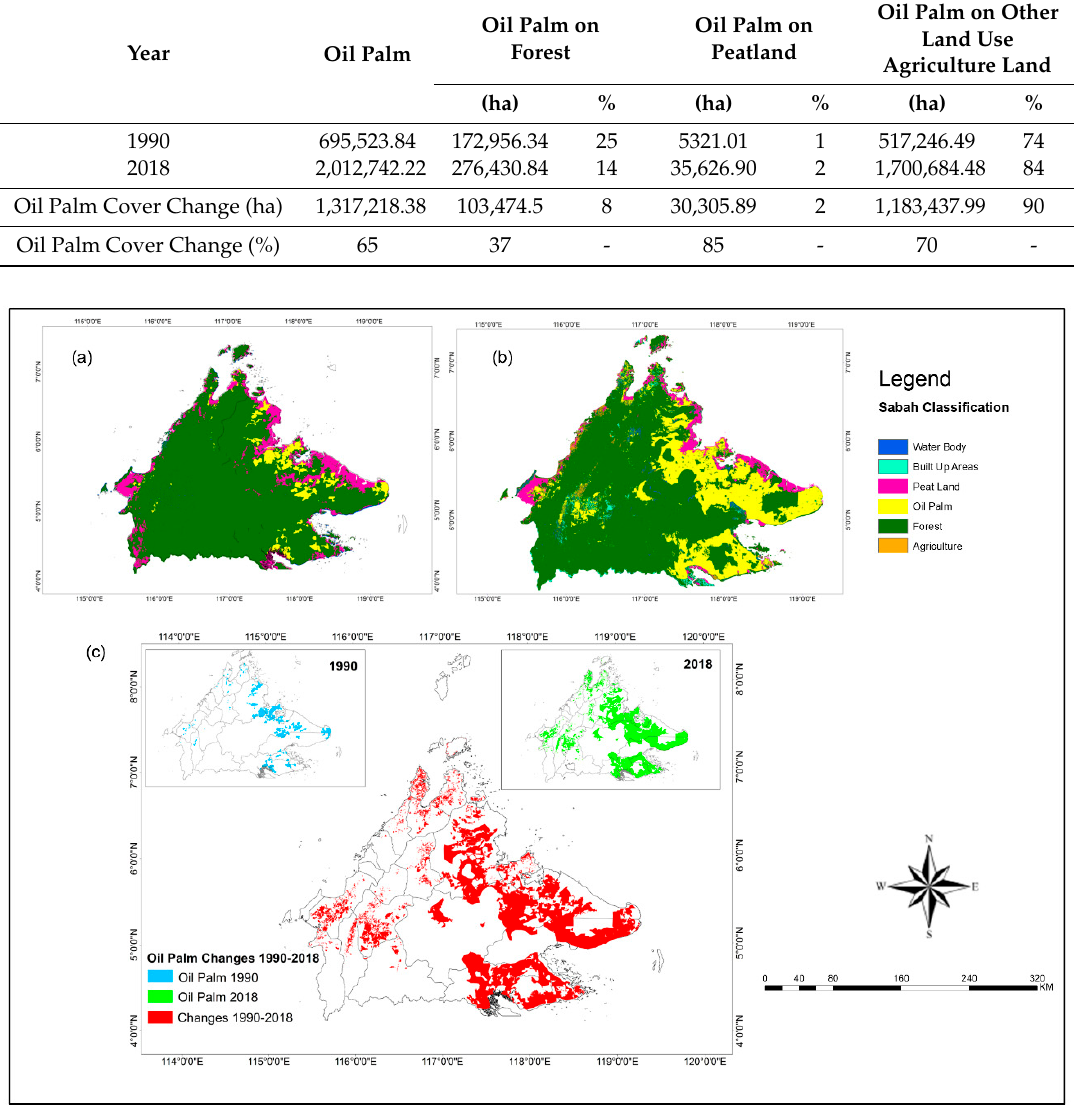
Figure 8. Sabah oil palm development: ( a ) 1990 as the initial state, ( b ) 2018, and ( c ) changes in oil palm development.